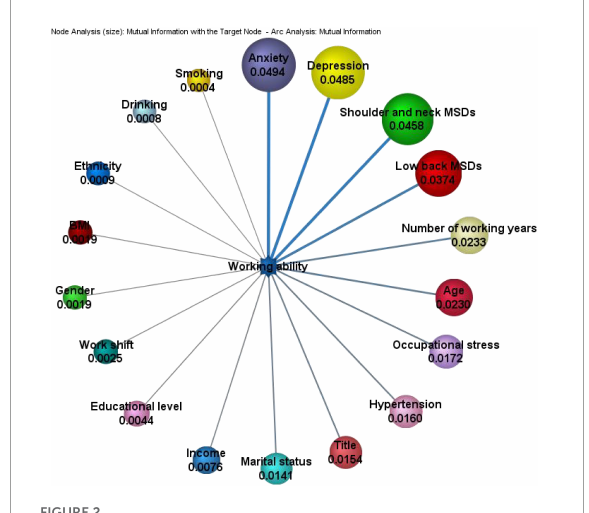
FIGURE2 Sensitivity analysis of supervised Bayesian network. The numbers in the figure are calculated by MI. The sizes of the circles and the thickness of the lines are proportional to the importance of the influencing